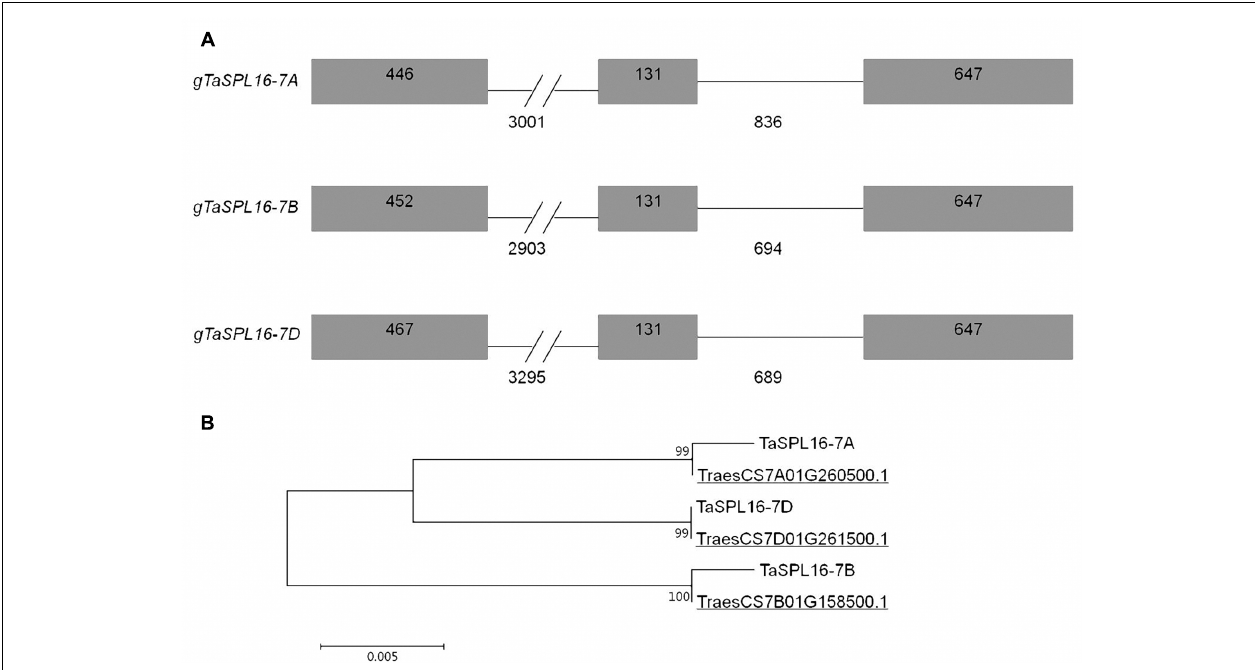
FIGURE 2 | The structures of TaSPL16 homoeologs and alignment of the deduced TaSPL16 proteins in wheat. (A) The structures of the TaSPL16 homoeologs. Black boxes indicate exons, and the lines between exons denote introns. The longer introns are condensed as signified by a double slash (//). Numbers indicate exon or intron size (bp). (B) ClustalW alignment of the deduced protein TaSPL16-7B with TaSPL16-7A and TaSPL16-7D. The underlines indicate the protein ID of TaSPL16 in the fully annotated reference genome of wheat (International Wheat Genome Sequencing Consortium [IWGSC], 2018). Scale bar indicates the average number of amino acid substitutions per site. The values next the branches indicate the identity of the two corresponding TaSPL16 protein.